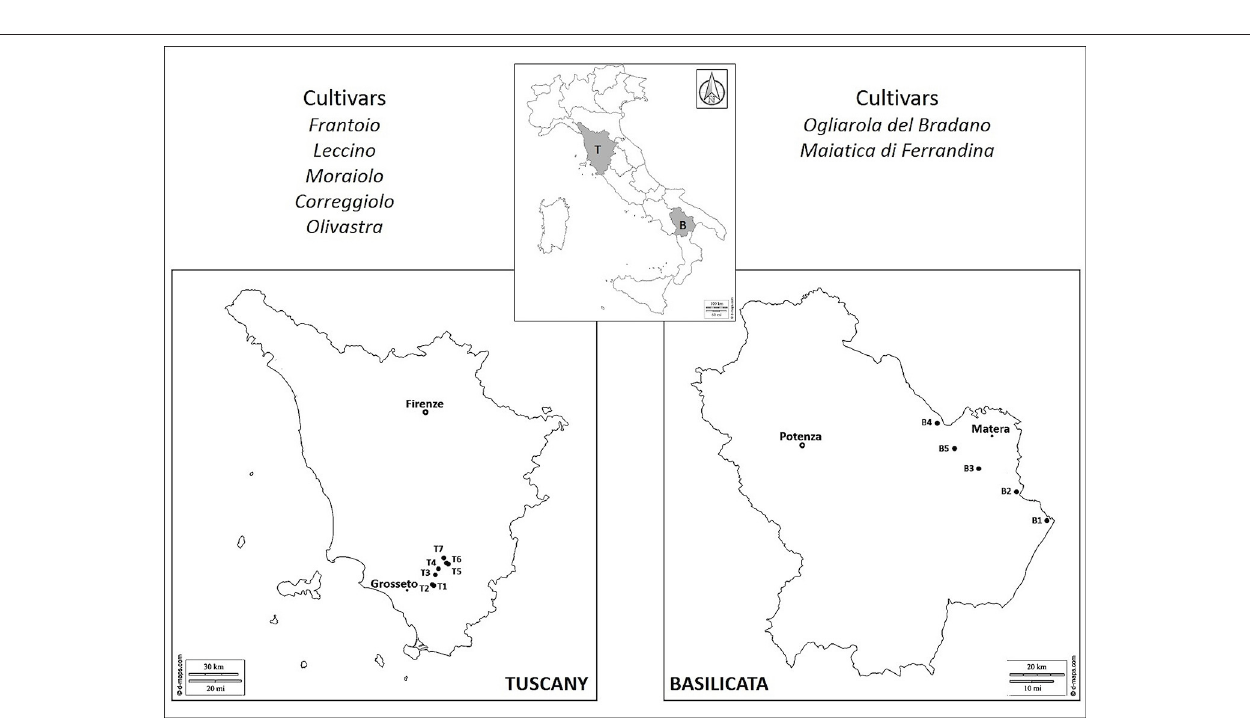
FIGURE 1 | Distribution map showing the production quantities by country, estimated in tons of olives (in the legend) redrawn from FAOSTAT database for 2017.